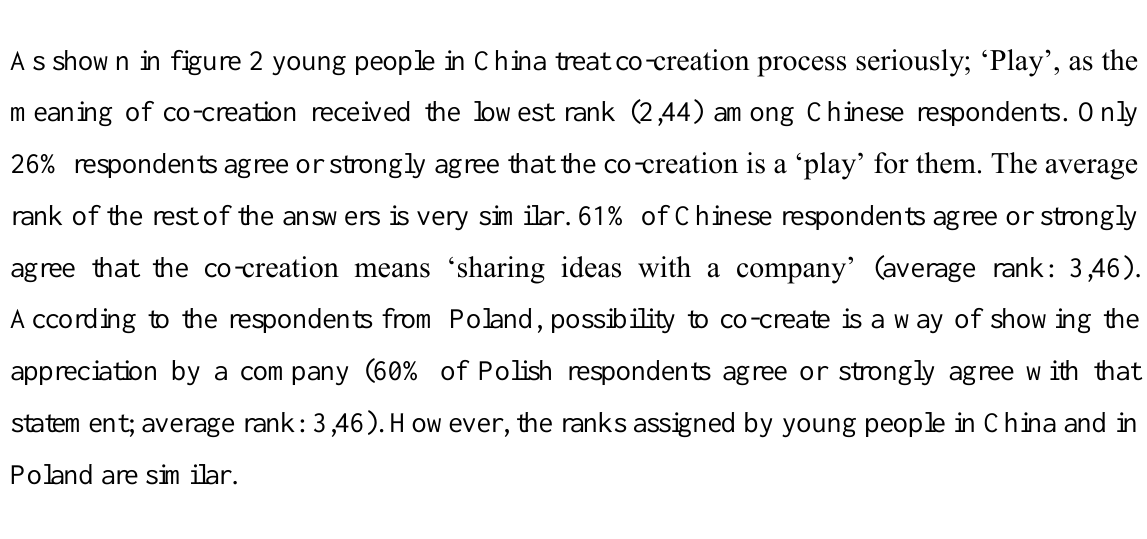
Fig. 2: Average rank assigned to the meaning of the co-creation by the surveyed young people in Poland and in China Source: own collaboration based on the survey